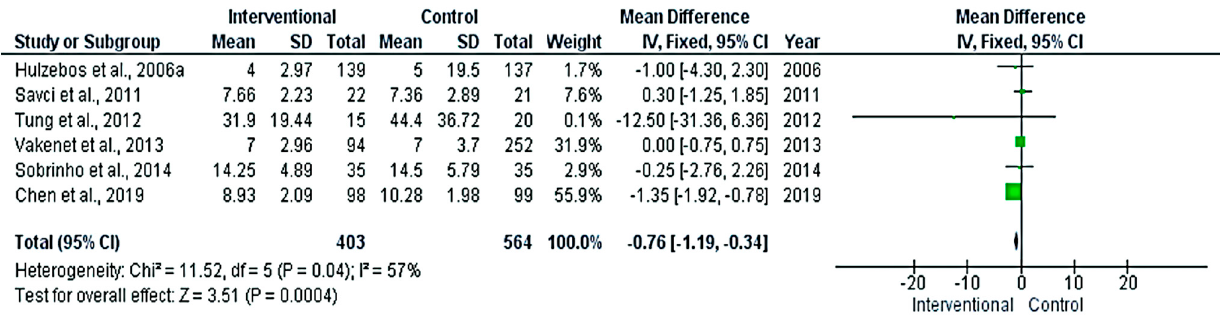
Figure 4. Forest plot evaluating mechanical ventilation duration in the included studies.